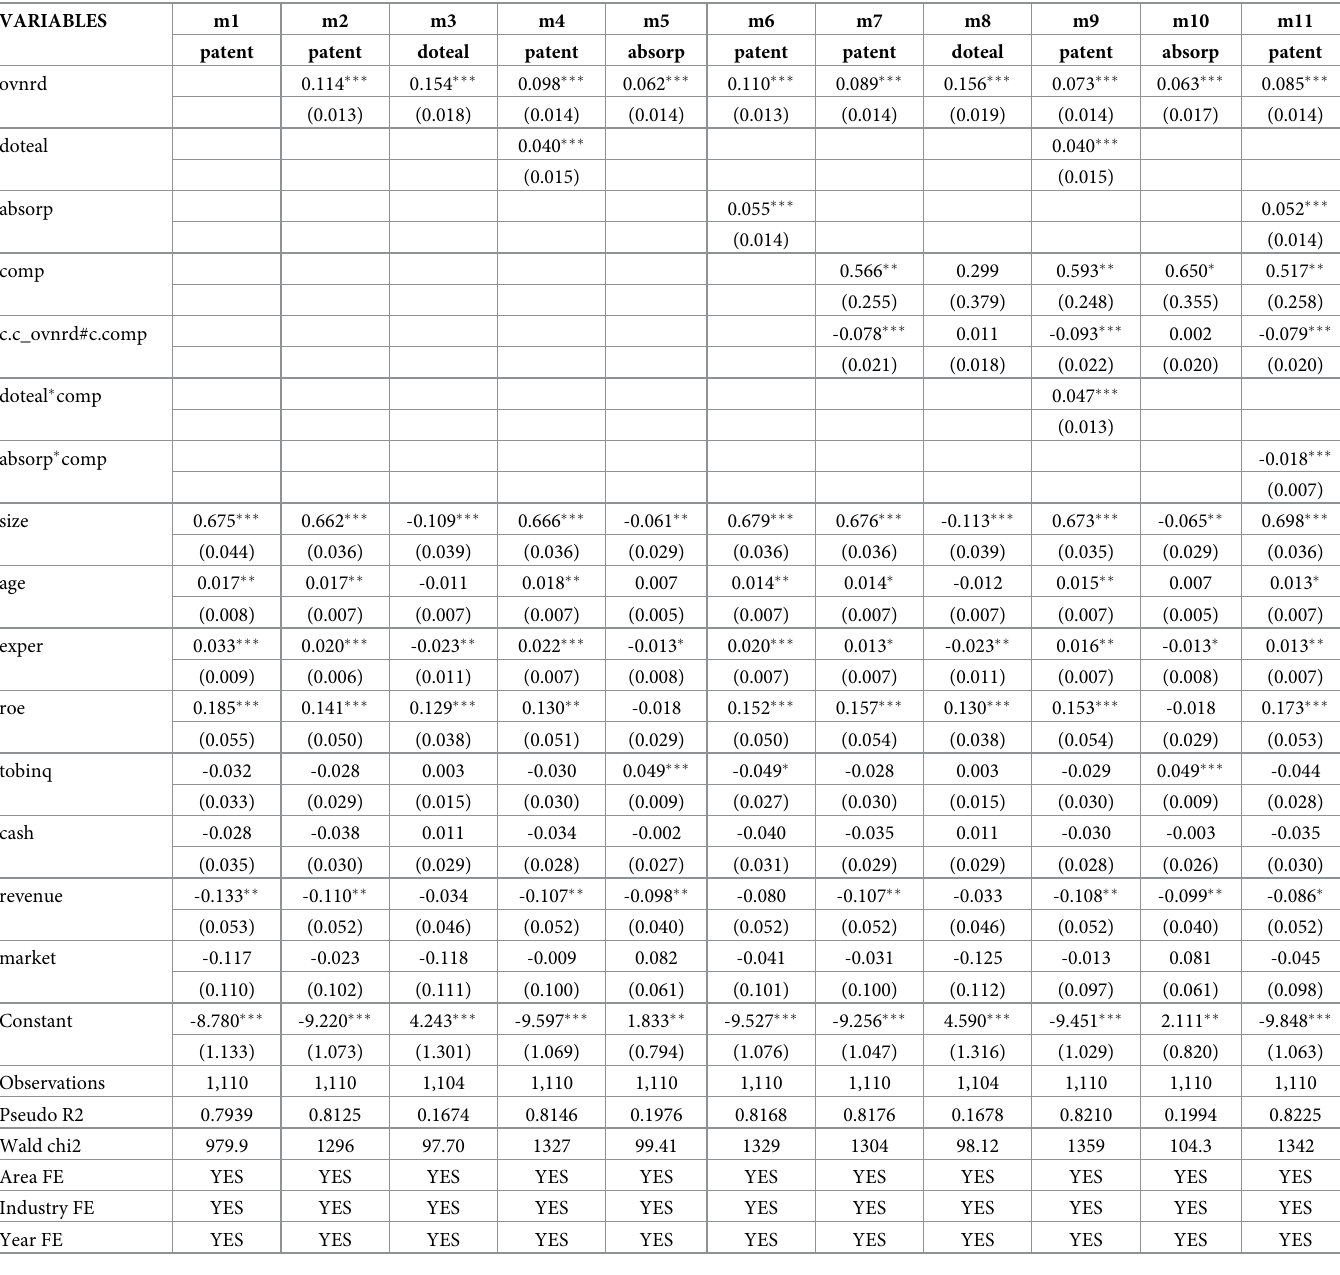
Table 7. Robustness test results based on R&D internationalization variable